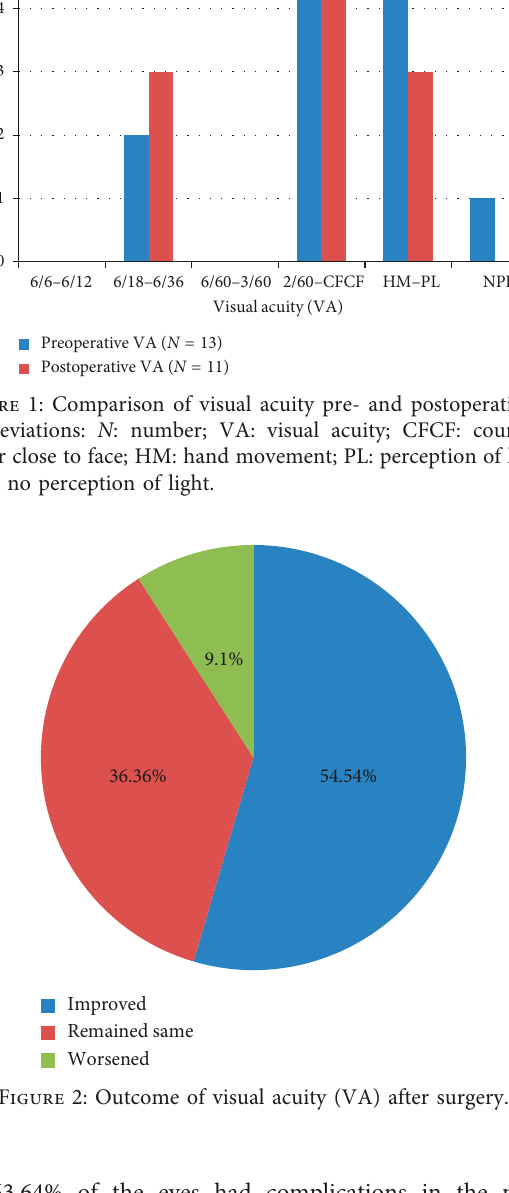
Table 3: Postsurgical record ( N